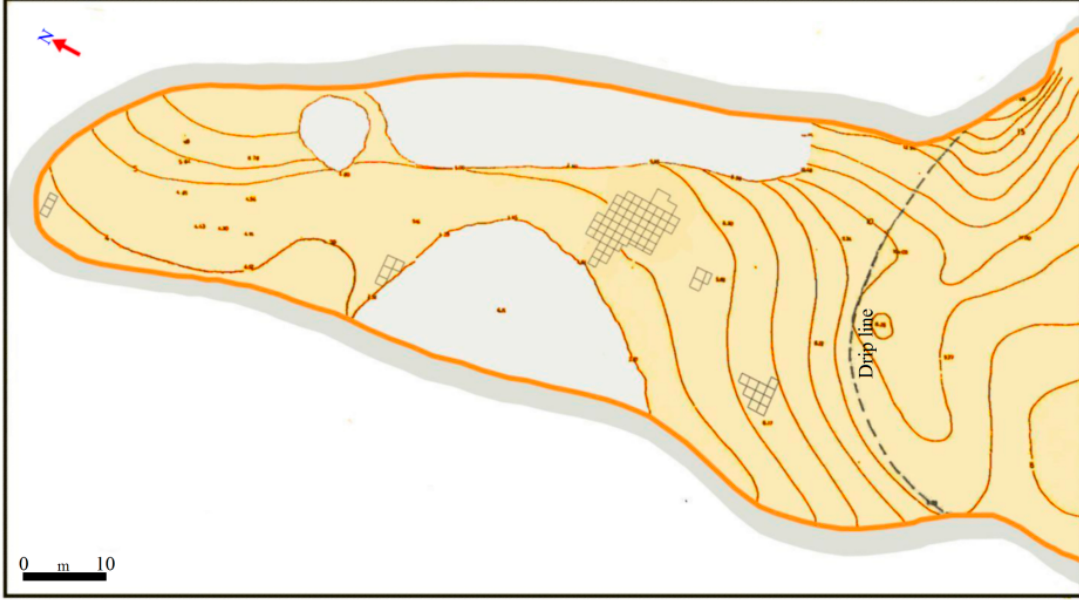
Figure 6. Map of the CM showing the locations of the author’s excavations.